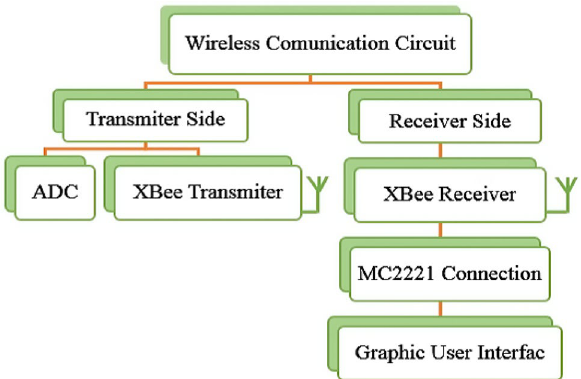
Fig. 7 Block diagram of the wireless communication